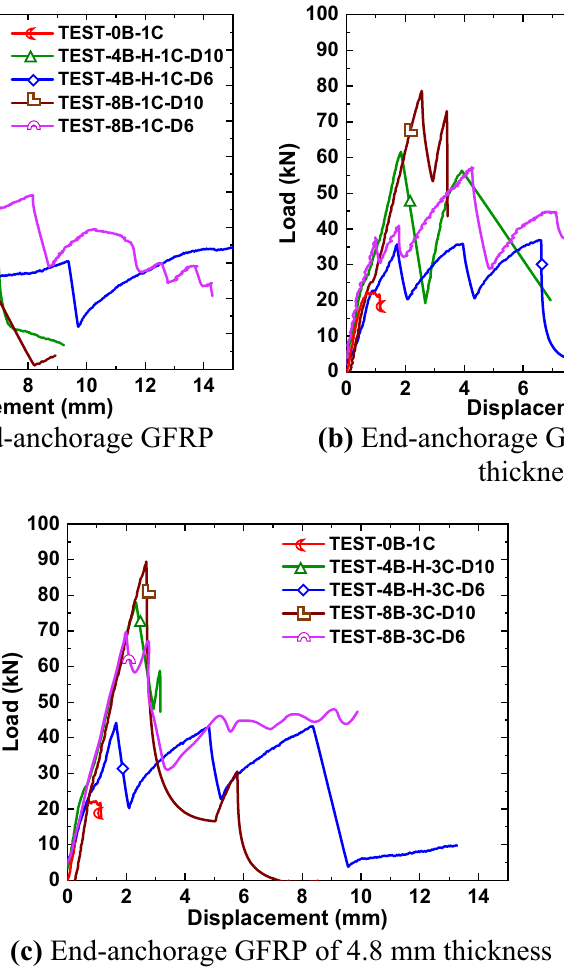
Fig. 6 Typical load versus mid-span deflection curves with variation in diameter of